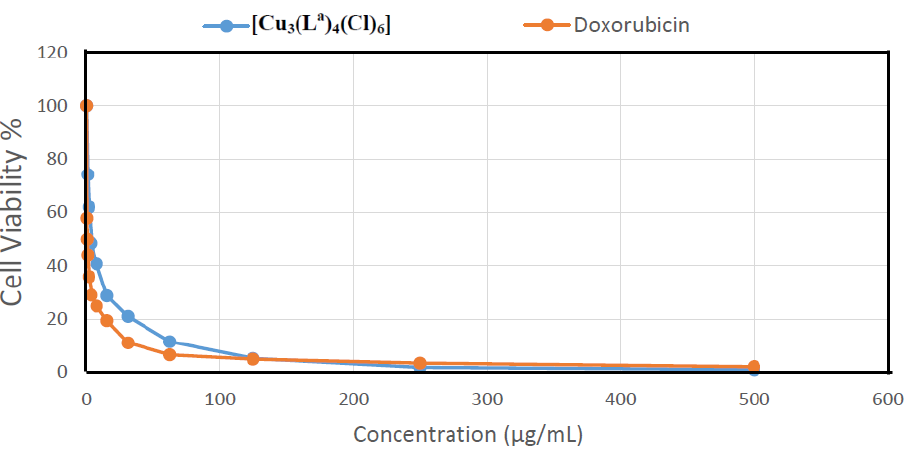
Figure 9. Cytotoxic activity of the [Cu 3 (L a ) 4 (Cl) 6 ] complex versus colon carcinoma (HCT-116 cell line).